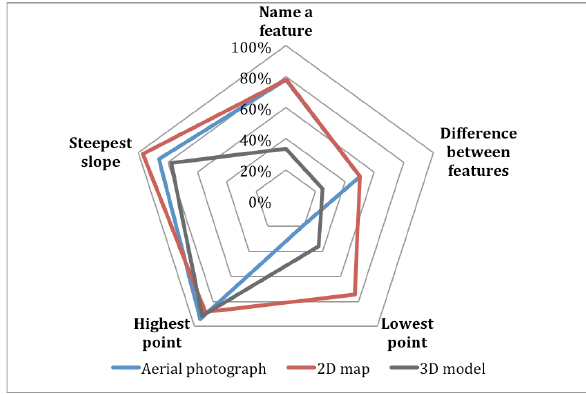
Figure 3. Radar diagram showing the percentage of correct answers for each geovisualization in the controlled experiment